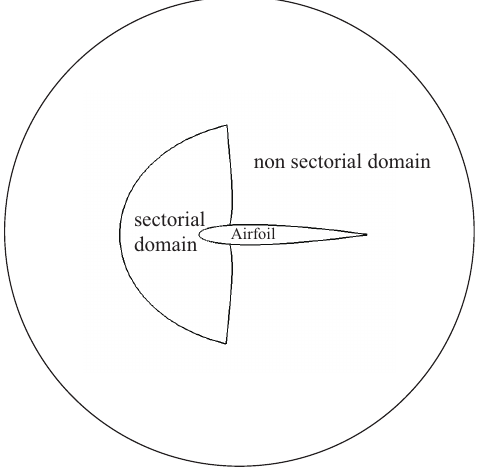
Figure 3. Region division of the computational grid.